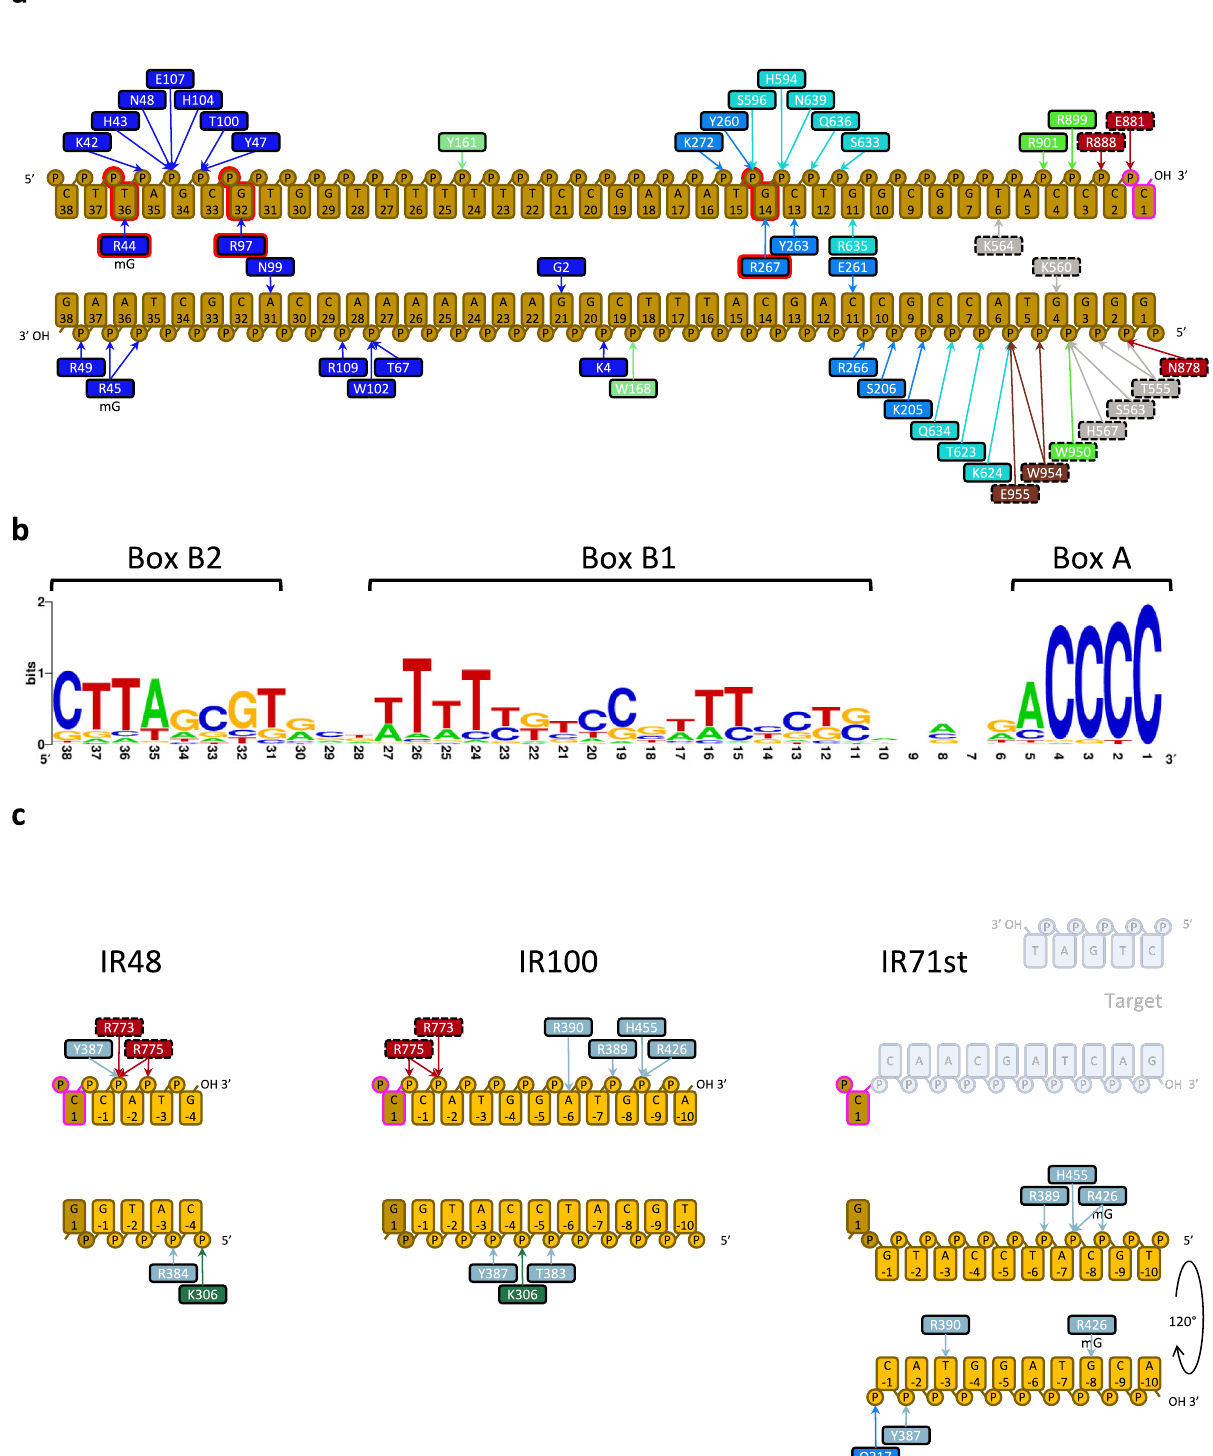
Fig. 4 | Schematic representation of TnpA-DNA interactions and conservation of the recognition sequence. a Interaction of TnpA with IR sequence. Interacting residuesarecolorcodedbyTnpAdomainasinFig.1.Residuesandbasesdisplaying highcovariationinTn3familyareshownwithredborderline. b Conservationofthe recognition sequence. Three conserved regions named Box A, Box B1, and Box B2